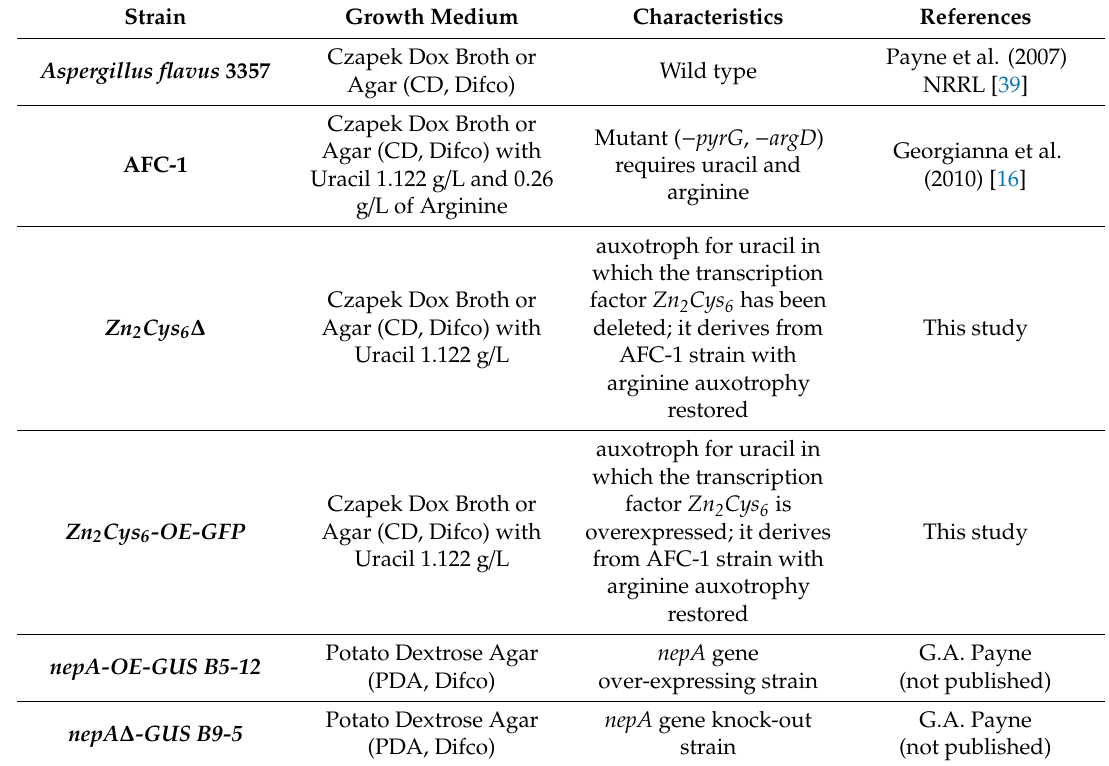
Table 1. A. flavus